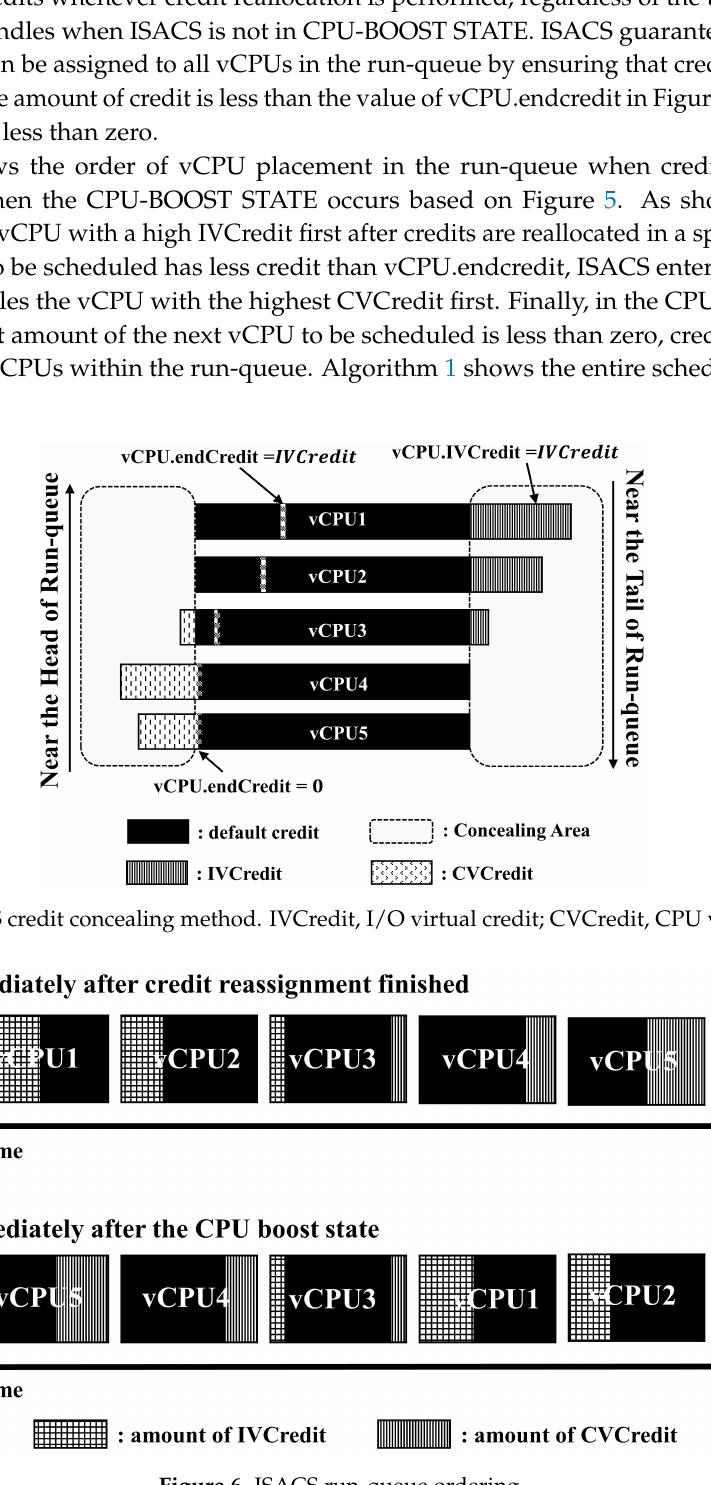
Figure 6. ISACS run-queue